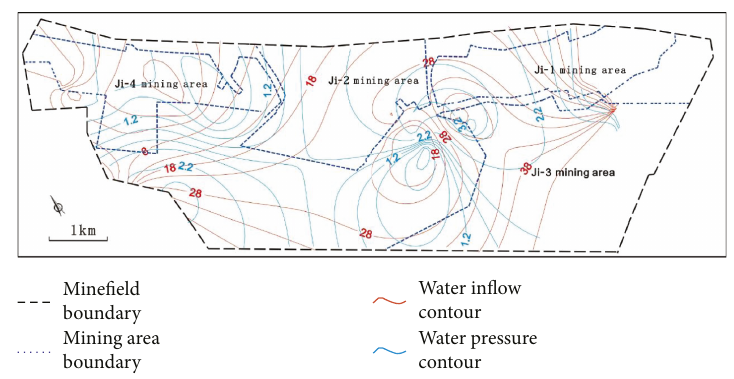
Figure 3: The contour map of water in fl ow and water pressure.